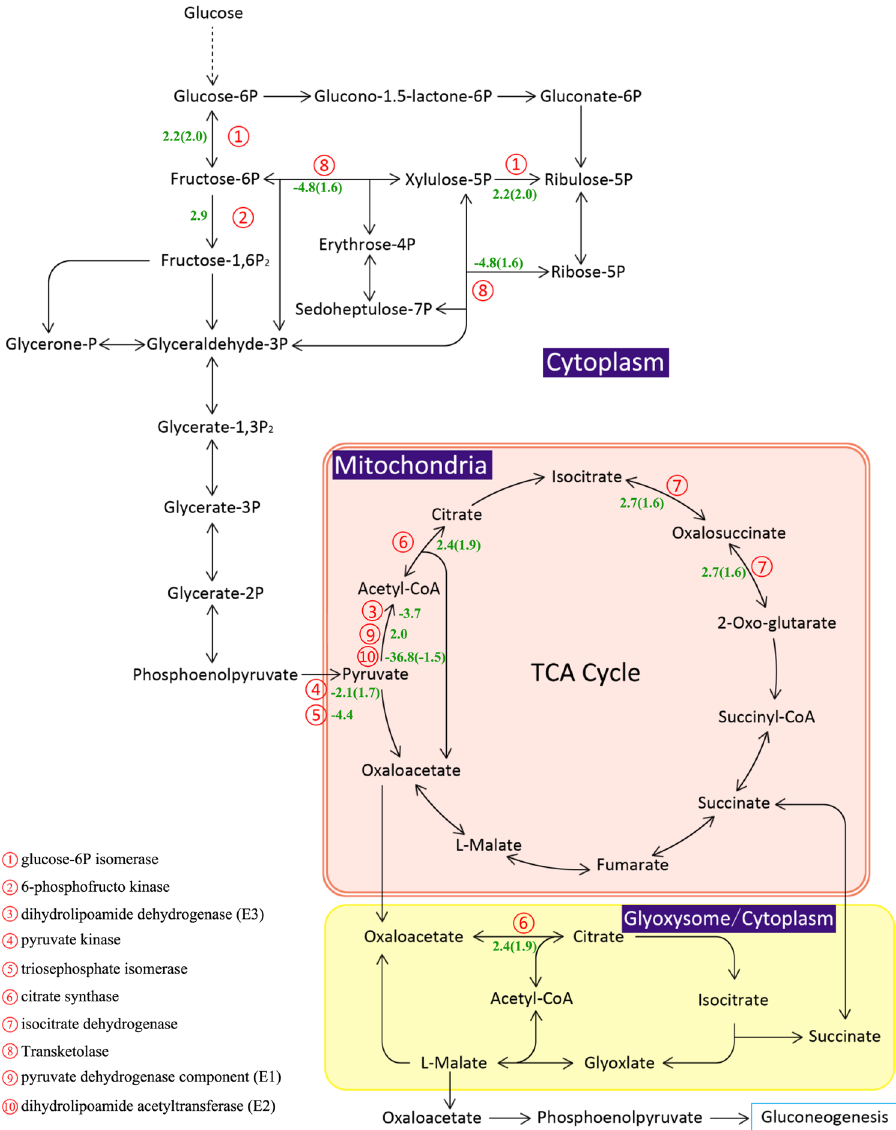
Figure 5. The glycolysis, pentose phosphate, TCA cycle and oxidative phosphorylation pathway in T. pseudonana during N depletion compared to N replete conditions (ND vs. NR). The serial number represent the related enzyme and the negative number indicate the down-expressed fold change of the genes (The opposite is up-expressed). The Inside the parentheses is the protein fold